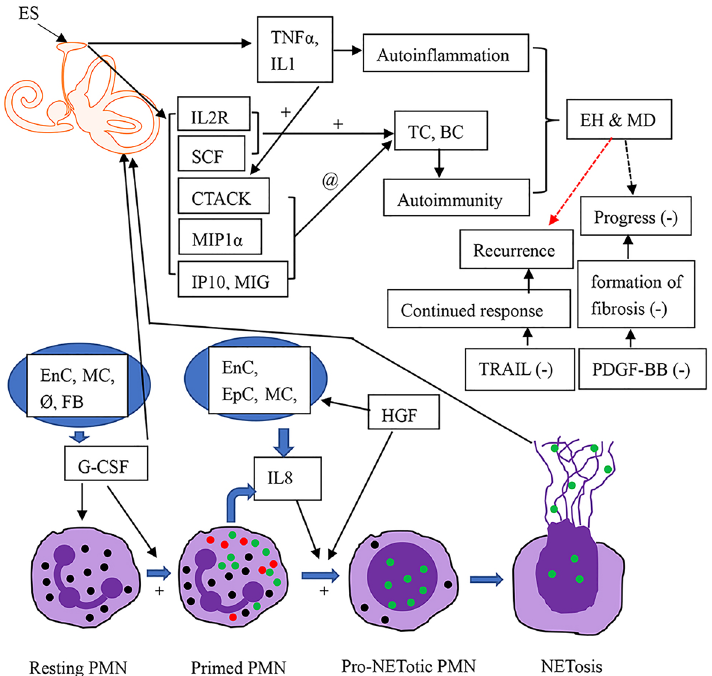
Figure 6. Involvement of NET formation in initiating the pathological process of MD. BC: B cell; EH: endolymphatic hydrops; ES: endolymphatic sac; EnC: endothelial cells; EpC: epithelial cells; FB: fibroblasts; MC: monocytes; PMN: polymorphonuclear neutrophil; Ø: macrophages. Green dots: key components of the NETotic cascade, such as protein arginine deiminase-4, neutrophil elastase, and myeloperoxidase; red dots: proinflammatory cytokines, such as IL8 and TNFα; TC: T cell. “+”: promotion; “−”: downregulation; “@”: recruitment or homing. Dashed arrow: adjustment of the MD